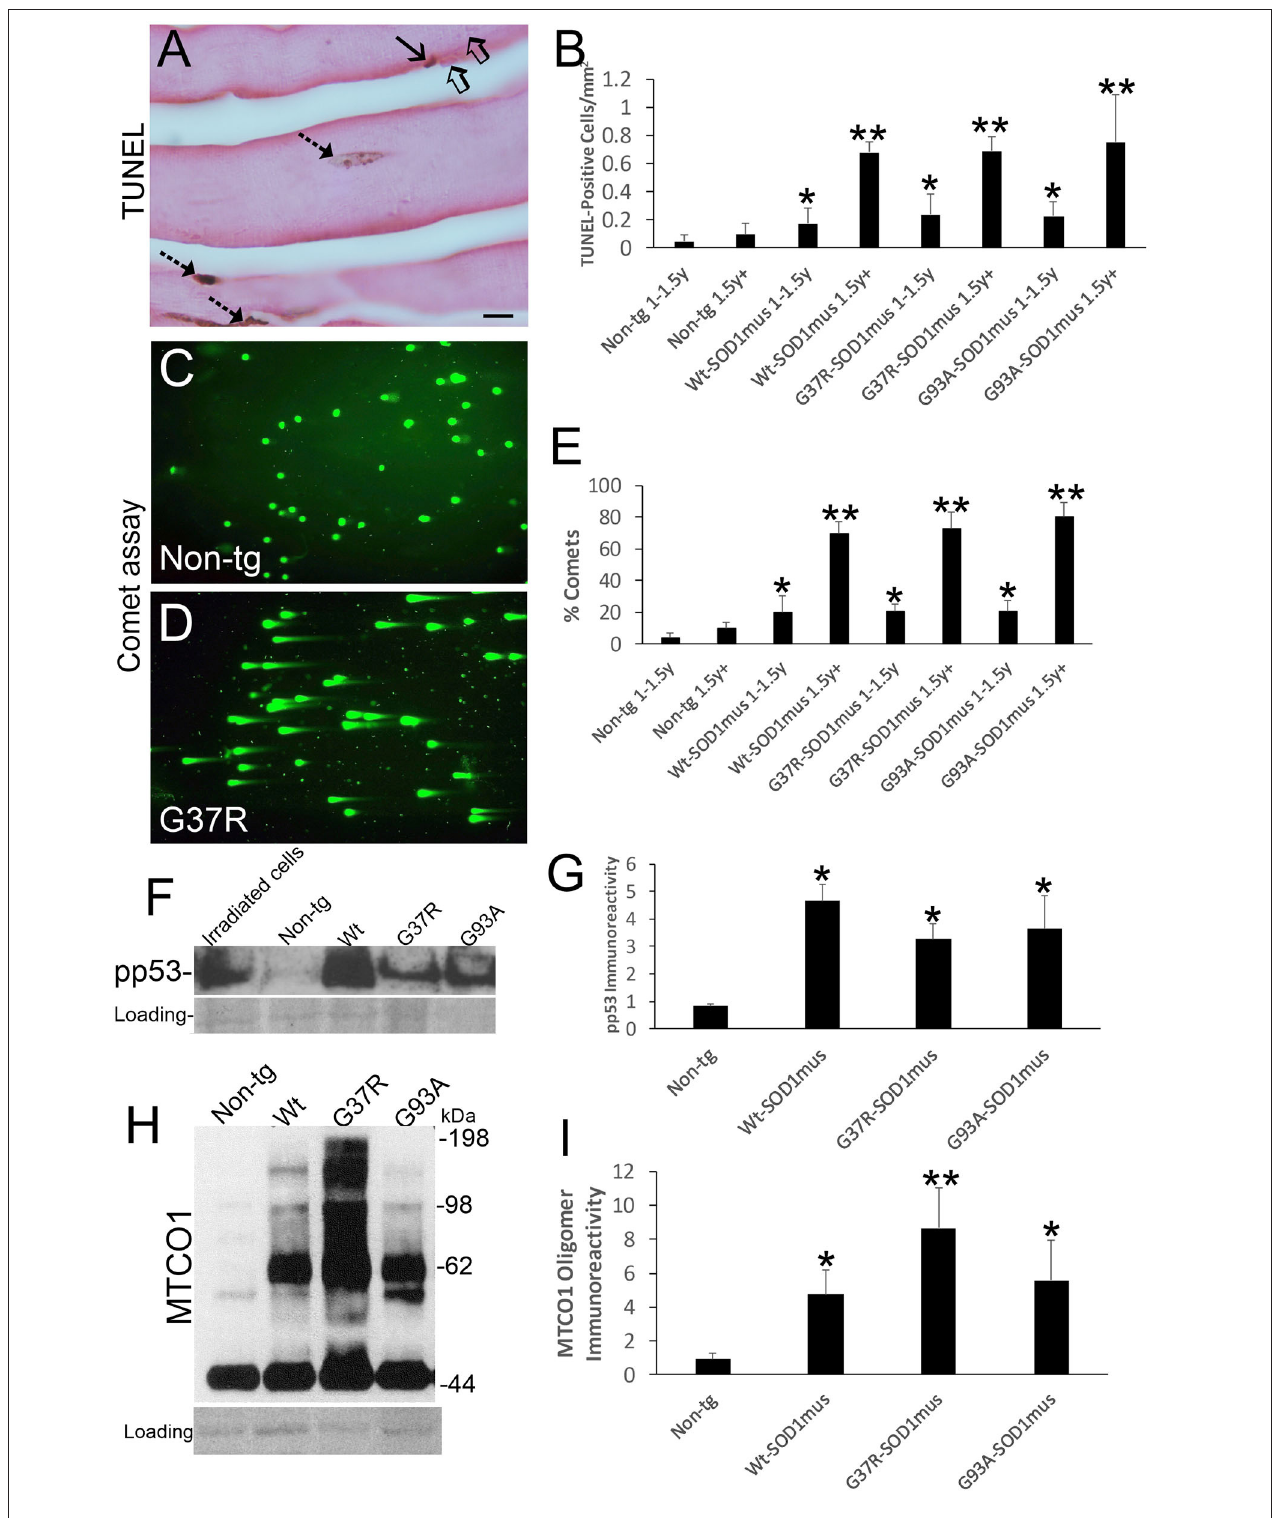
FIGURE 4 | DNA damage, p53 activation, and mitochondrial complex IV proteinopathy occur in skeletal muscle of hSOD1 mus mice. (A) TUNEL visualized DNA-DSB accumulation in myonuclei (hatched arrows) and a putative satellite cell (solid arrow). Unlabeled nuclei are present (open arrows). Scale bar = 15 µ m. (B) TUNEL positive nucleus accumulation in skeletal muscle is age-related in hSOD1 mus mice (mean ± SD, * p < 0.05; ** p < 0.001). (C,D) Alkaline comet